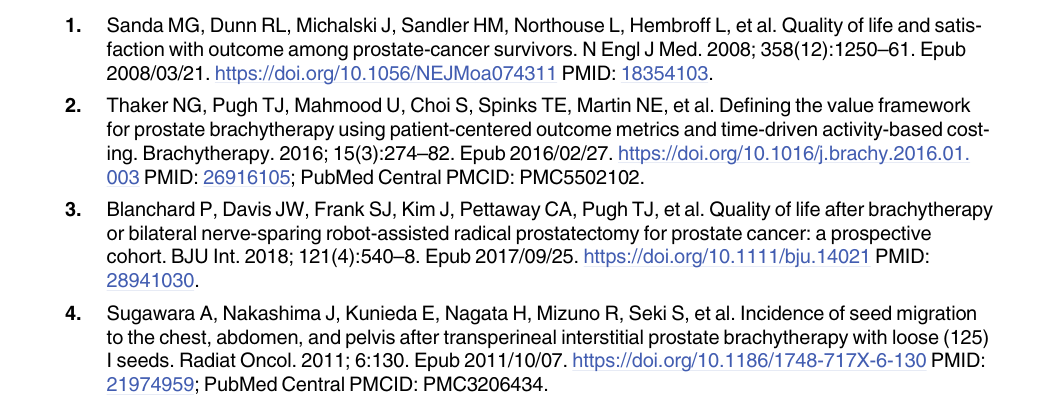
S1 Fig. Linear correlation of total activity between the preoperative and intraoperative plans in cases where additional radioactive seeds were inserted. S2 Fig. Three-dimensional display of seed distribution relevant to the prostate and adja- cent organs. A few seeds are located within the emerald-colored shade that indicates the plan- ning target volume, constructed by adding a uniform margin around the red-colored